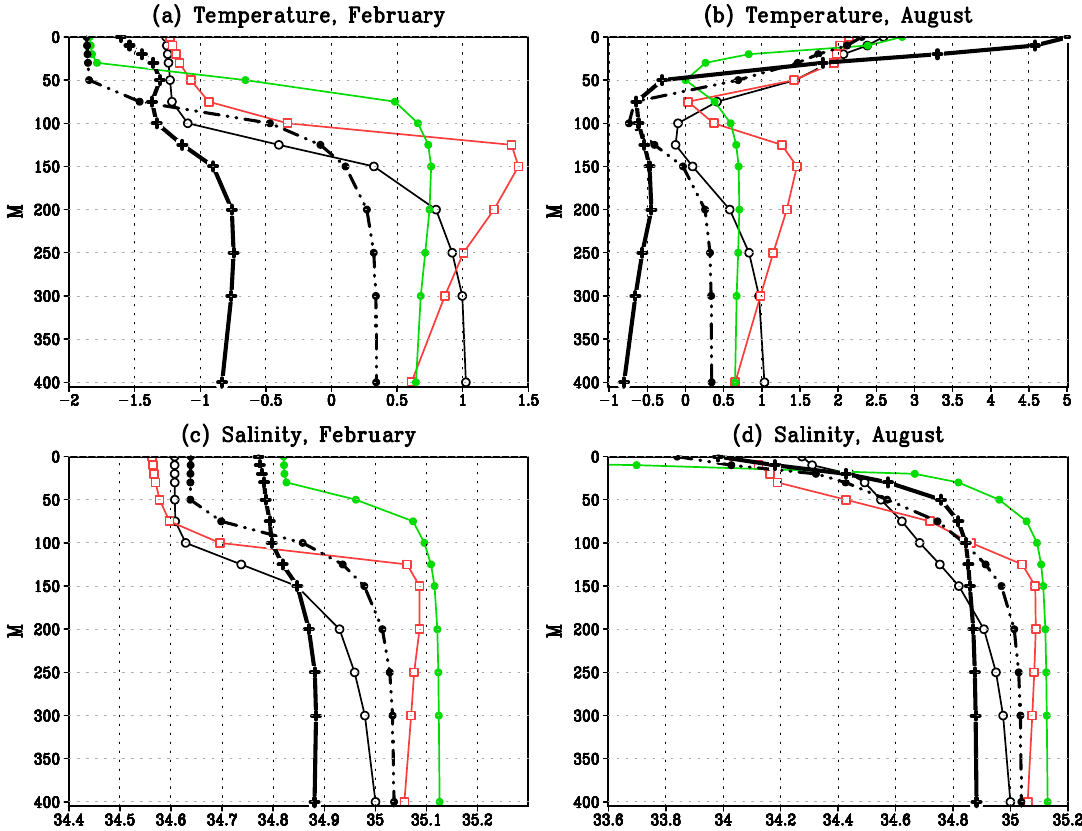
Figure 5. T (in ◦ C) and S (in PSU) profiles for February and August averaged for 1980–2009 in the recirculation region of the West Spitsbergen Current (center of the one-degree model cell near 75 ◦ N, 2 ◦ W): the columns are February ( left ) and August ( right ), rows are temperature ( top ) and salinity ( bottom ). Black solid thick line with crosses represents the climate; Green solid line with dark circles—EX1; Black dash/double dot line with dark circles—EX2; Black solid thin line with hollow circles—EX3; Red solid line with hollow